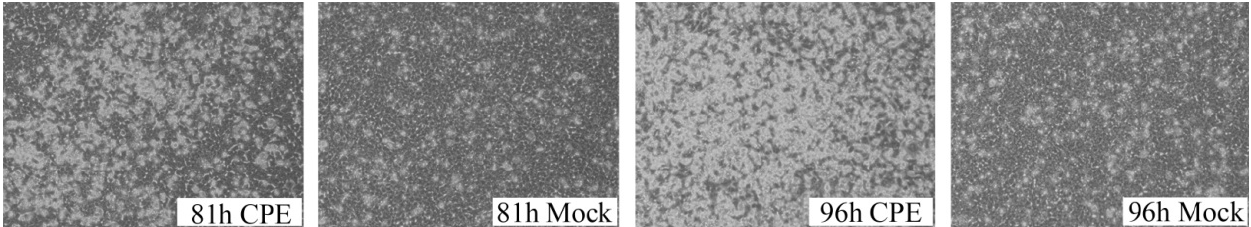
Figure 2. CPE post transfection (100×). CPE of BSR T7/5 cells post transfection at 81 h and 96 h, respectively. White pyknotic cells appeared at 81 h after transfection and spread to cover almost the whole well at 96 h after transfection, whereas cells in the Mock remained normal.